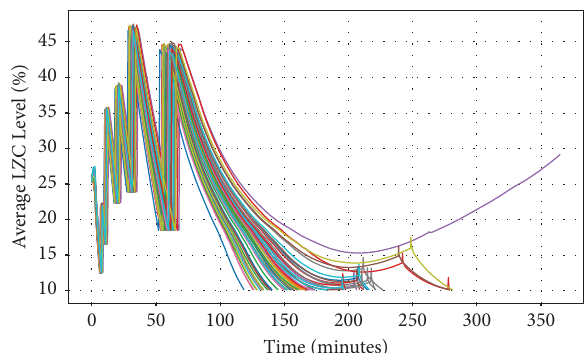
Figure 10: Efect of nuclear data perturbation–59% FP